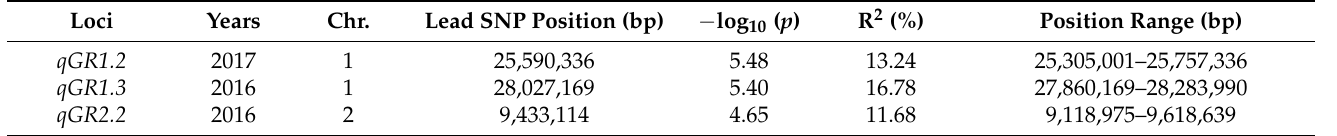
Table 3. Loci uniquely identified in 2016 or